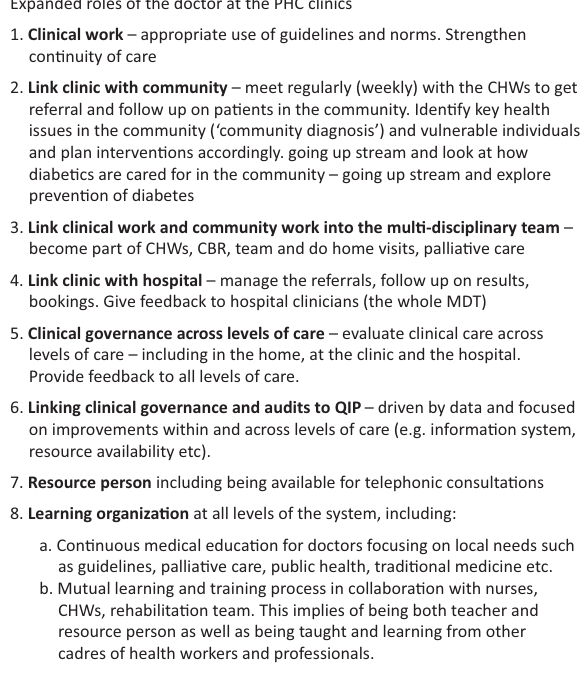
FIGURE 1: Expanded roles of the doctor at the primary healthcare clinic.